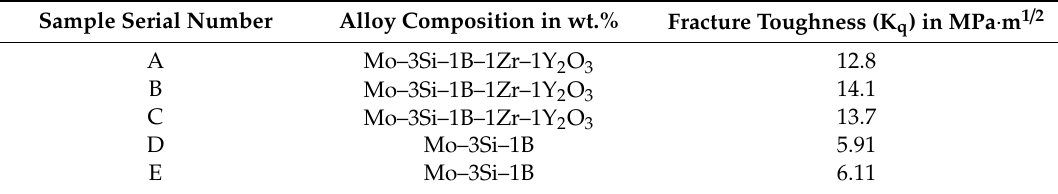
Table 2. Calculated fracture toughness values based on bending tests.